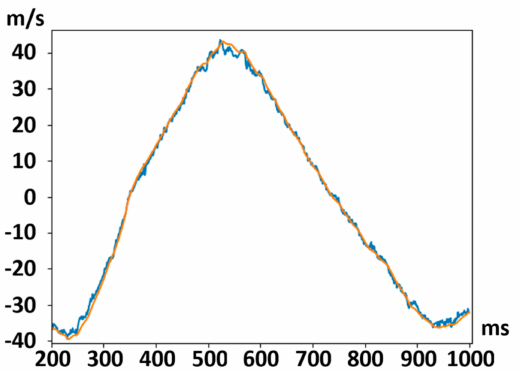
Figure 16. Output response of 3 layers EKF with actually swaying within ± 40